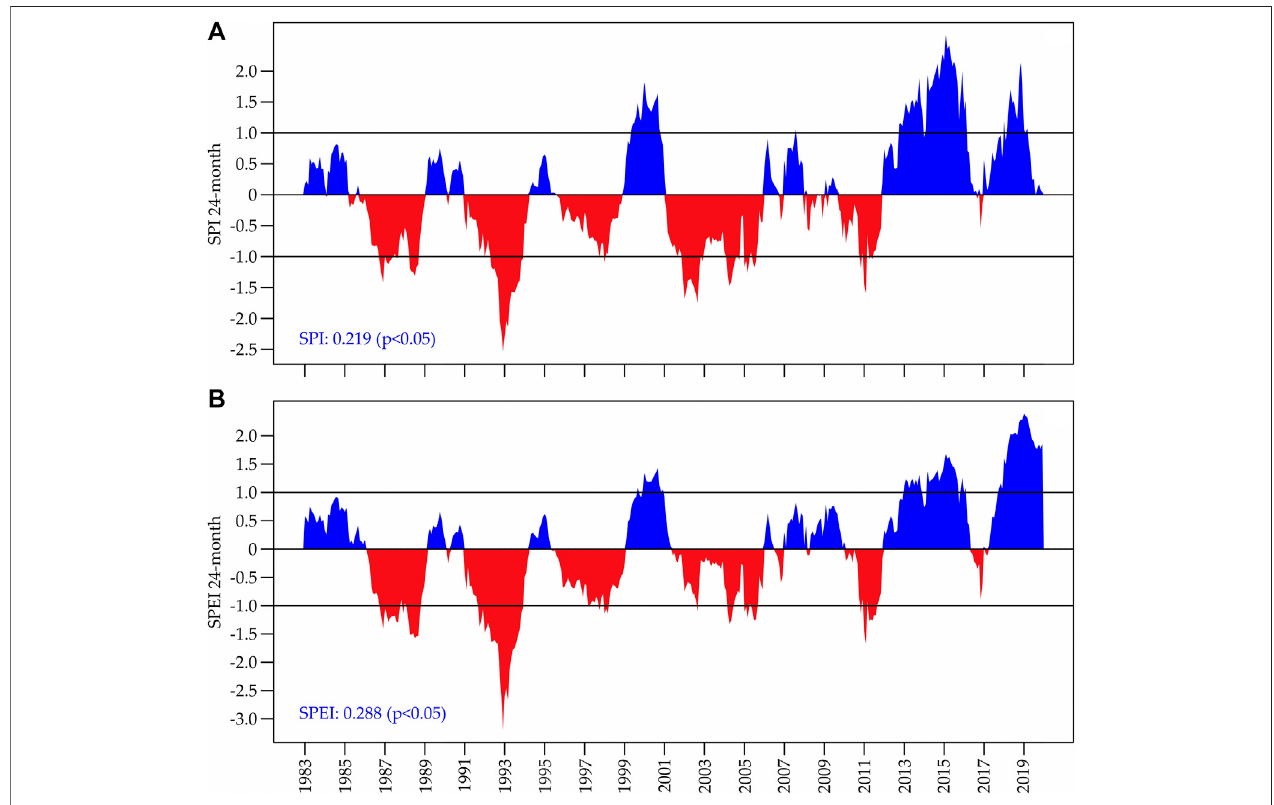
FIGURE 7 | SPI 24-months (A) and SPEI 24-months (B) for the 1981 – 2019 period with wet, normal and drought bands. The amount of change (including the statistical signi fi cance) for each index is shown at the left bottom of each subgraphic.